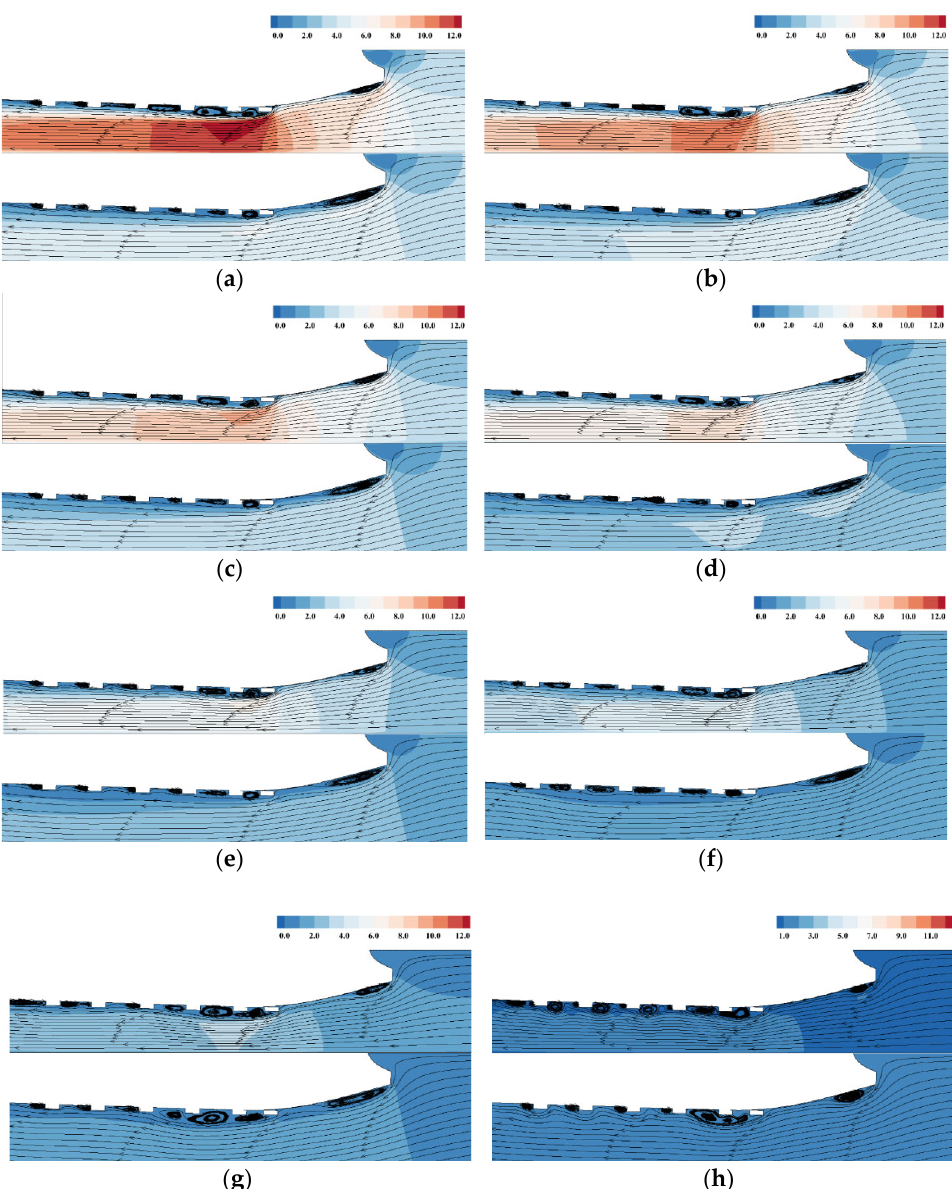
Figure 12. Distribution of velocity field and streamlines: ( a ) 4.0 m/s, ( b ) 3.5 m/s, ( c ) 3.0 m/s, ( d ) 2.5 m/s, ( e ) 2.0 m/s, ( f ) 1.5 m/s, ( g ) 1.0 m/s, and ( h ) 0.5 m/s. (Note: Upper object in the figure for the hull without aft poppet and the lower object for the hull with aft poppet.)